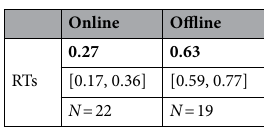
Table 3. Cohen’s d calculated using the stimulation timing as moderator.